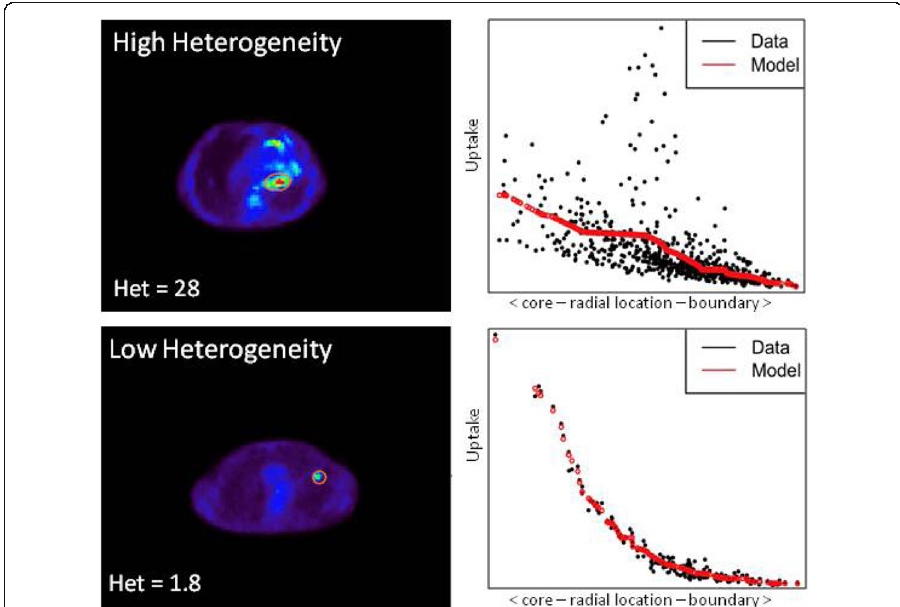
Fig. 3 Illustration of the HET quantitation on two NSCLC studies, with high (top) and low (bottom) heterogeneity. The corresponding scatterplots (right) illustrate the representation of the volumetric tracer uptake (black dots) as a function of radial position within the ideal ellipsoid pattern, from core (left hand side of the x-axis) to the volume boundary (right hand side of the x-axis). The HET variable quantifies the lack of goodness-of-fit of the data-adaptive regression model (red) derived from this representation, thus assessing how well the idealized ellipsoidal pattern describes the observed uptake